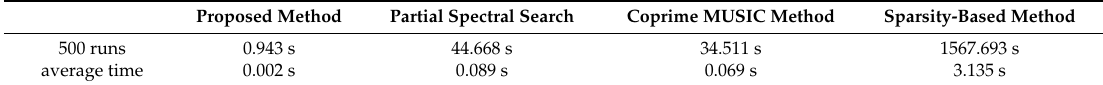
Figure 4. The RMSE performance of all examined methods: ( a ) RMSE versus the input SNR; ( b ) RMSE versus the number of snapshots; second example. Table 2. Running time of each coprime array DOA estimation method.